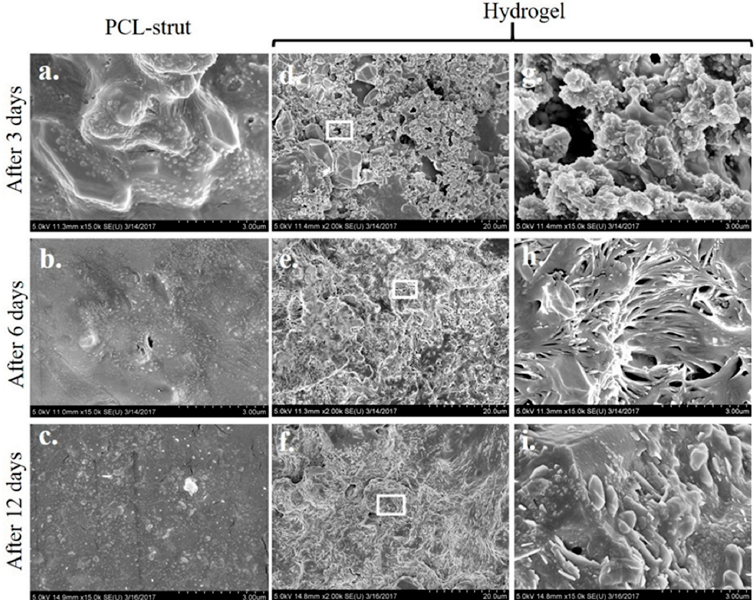
Figure 6. High magnification SEM images of freeze-dried PCL/ hydrogel samples after 3 ( a , d , g ), 6 ( b , e , h ), and 12 days ( c , f , i ) of immersion in SBF. The g , h , and i are the magnified images of regions marked in micrographs d , e , and f , respectively. Results showed the deposition of apatite on both PCL as well hydrogel ( a , d ) in the initial period (3 days) of SBF immersion. A lower amount of apatite on PCL struts than hydrogel after 6 and 12 days may be due to the dissolution of deposited apatite from PCL. Scale bar for ( a , b , c , g , h , i ) is 3 µm and for ( d , e , f ) 20 µm.